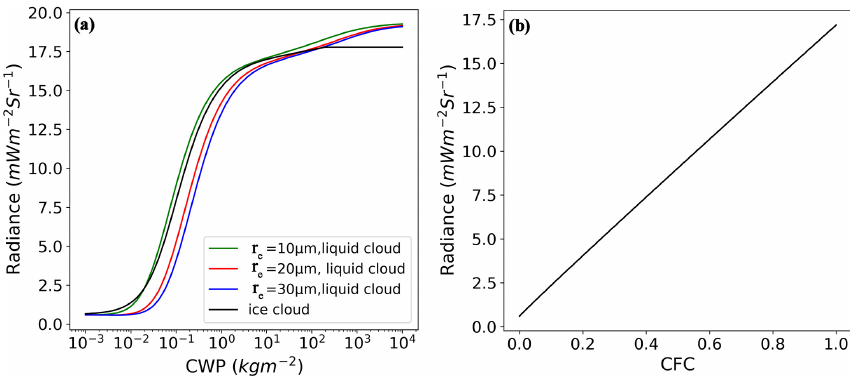
Figure 2. Dependence of AGRI channel 2 radiance on (a) cloud water path (CWP) and effective radius ( r e ), and (b) cloud fraction (CFC) for CWP of 10kgm − 2 and r e of 15µm. The simulation was performed with the “Deff” scheme for liquid water cloud optical properties and the Baren et al. (2014) scheme for cirrus optical properties. The solar zenith angle, viewing zenith angle, and relative azimuth angle were set to 25, 40, and 135 ◦ ,